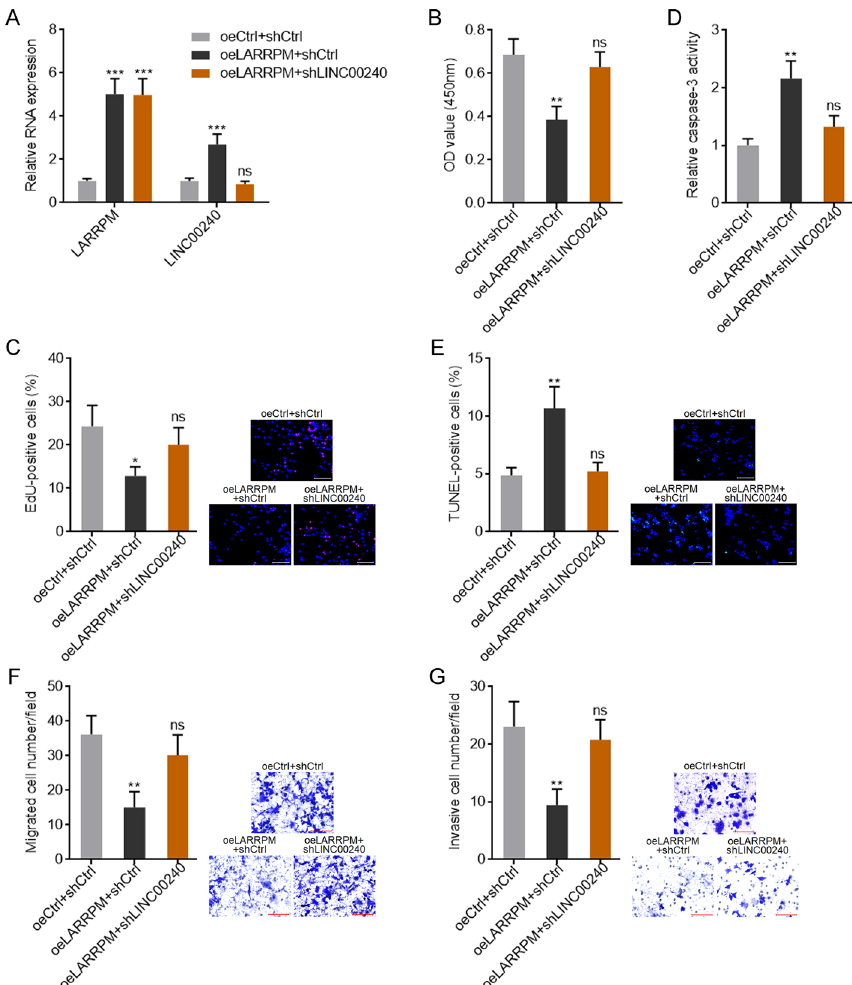
Fig. 5 Depletion of the LINC00240 reversed the roles of LARRPM in proliferation, apoptosis, migration and invasion of LUAD cells. a LARRPM and LINC00240 expression in A549 cells with LARRPM overexpression; LINC00240 depletion was detected by qRT‑PCR. b , c Cell proliferation of A549 cells with LARRPM overexpression and LINC00240 depletion was detected using the CCK‑8 assay ( b ) and EdU incorporation assay ( c ). Scale bar: 100 µm. Red color indicates the EdU‑positive cells. d , e Cell apoptosis of A549 cells with LARRPM overexpression and LINC00240 depletion was detected using the caspase‑3 activity assay ( d ) and TUNEL assay ( e ). Scale bar: 100 µm. Green color indicates TUNEL‑positive cells. f, g Cell migration and invasion of A549 cells with LARRPM overexpression and LINC00240 depletion were detected using the transwell migration assay ( f ) and transwell invasion assay ( g ). Scale bar: 100 µm. Results are shown as the mean based on three independent experiments. Asterisks indicate a significant difference at * P < 0.05, ** P < 0.01, *** P < 0.001; ns, not significant, by one‑way ANOVA followed by Dunnett’s multiple comparisons